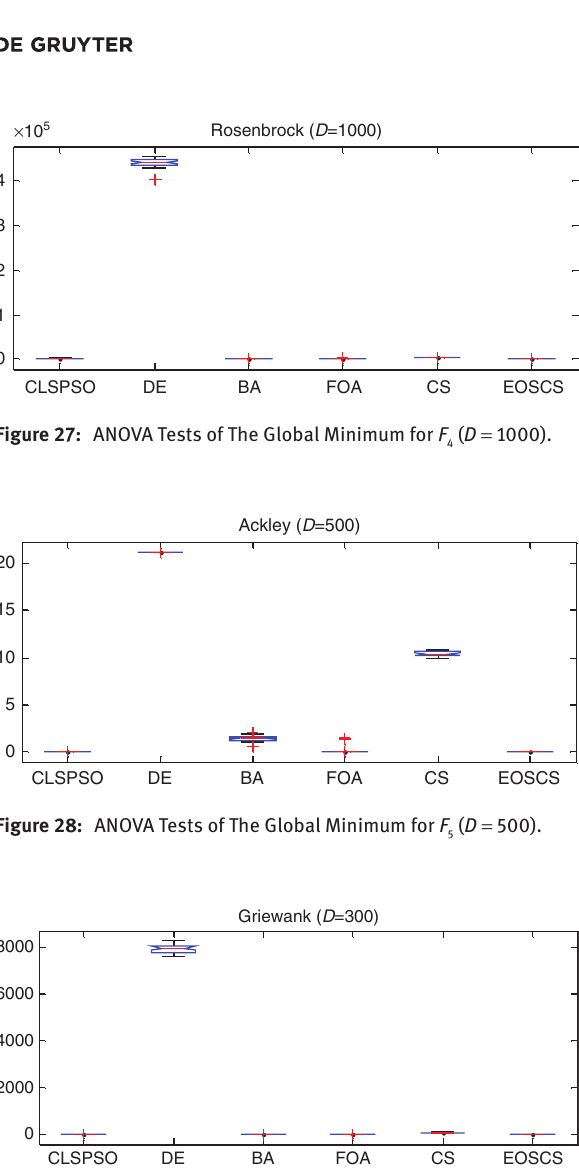
Figure 29: ANOVA Tests of The Global Minimum for F